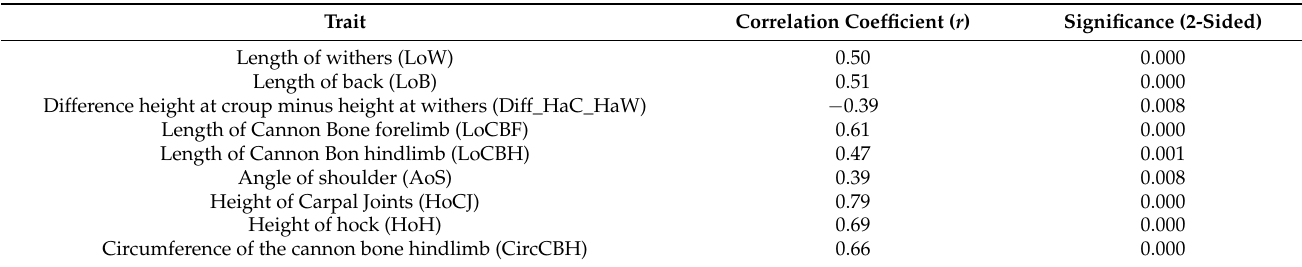
Table 4. Correlations to height at withers of nine